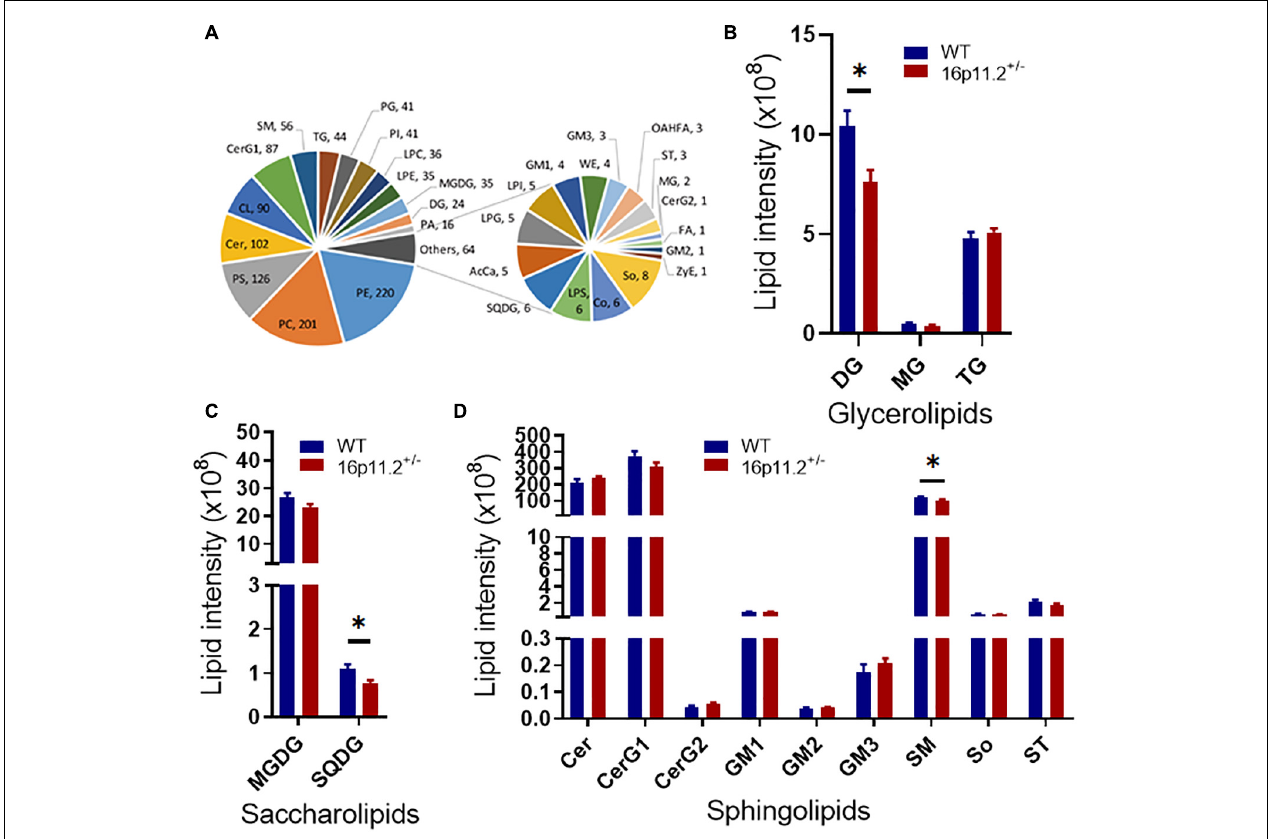
FIGURE 4 | Altered lipidomic profile in 16p11.2 ± striatum. Lipidomics analysis was performed with striatum tissues from P60 16p11.2 ± mice ( n = 5) and WT controls ( n = 6). A total of 32 lipid classes and 1218 lipid species were detected. (A) Charts illustrating all detected lipid classes. Each tail number indicates the number of lipid species detected. (B–D) Comparison of lipid classes of glycerolipids (B) , saccharolipids (C) , and sphingolipids (D) in 16p11.2 ± mice versus WT controls. Data were analyzed with unpaired t tests (mean ± SEM, * p < 0.05). Cer, ceramide; CerG1, hexosyl ceramide; CerG2, dihexosyl ceramide; DG, diglyceride; GM1, gangliosides 1; GM2, gangliosides 2; GM3, gangliosides 3; MG, monoglyceride; MGDG, monogalactosyldiacylglycerol; SM, sphingomyelin; So, sphingosine; SQDG, sulfoquinovosyldiacylglycerol; ST, sulfatide; TG,